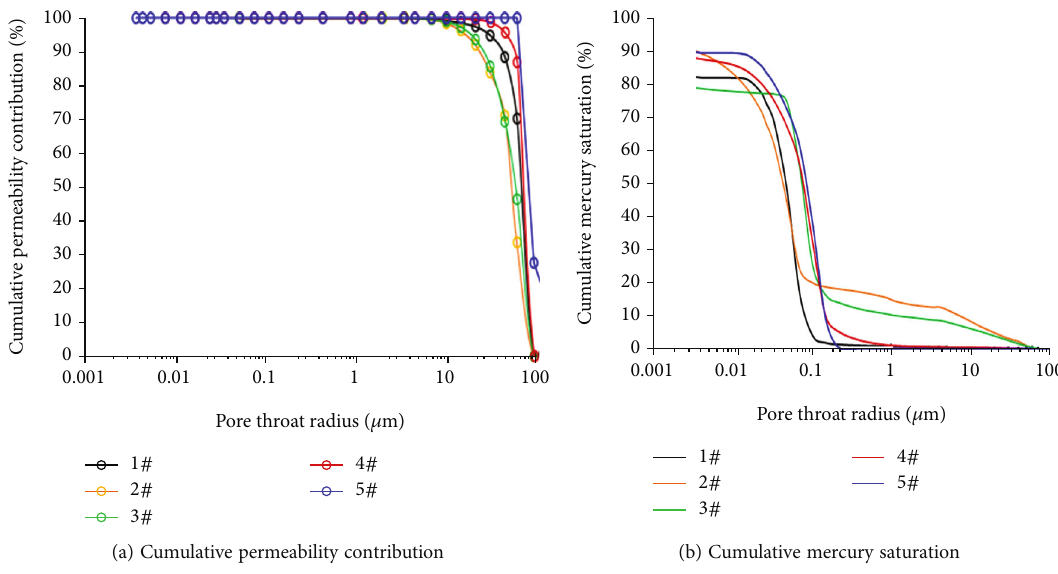
Figure 5: Control of pore throat size on porosity and permeability. Table 3: Control of macropores on reservoir physical properties of the III+IV oil group in Nanyishan Oil fi